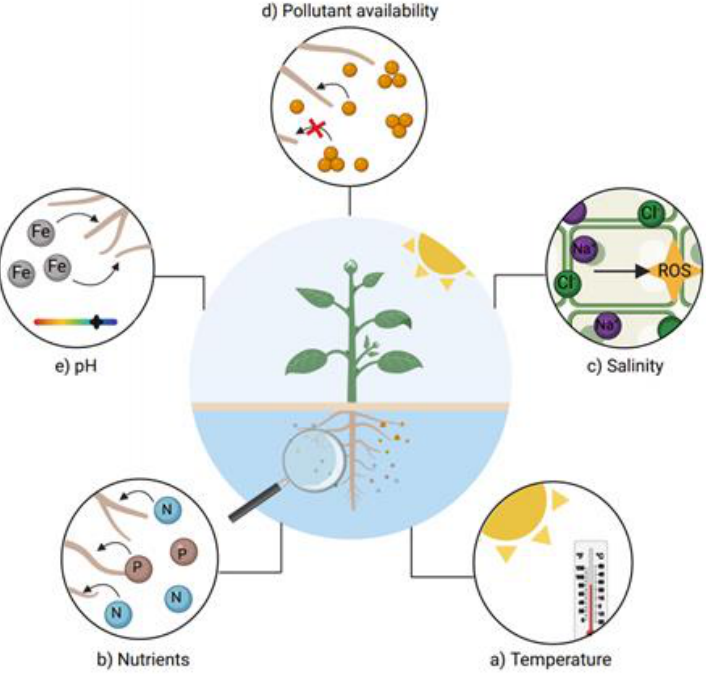
Figure 8. Main factors affecting water phytoremediation. Temperature, nutrients bioavailability, salinity, pollutant (HM) availability and pH are some factors that may delay phytoremediation processes. The interactions occurring in roots play an important role in systems where mobilization of the pollutant via the root is essential, such as HM phytoremediation.